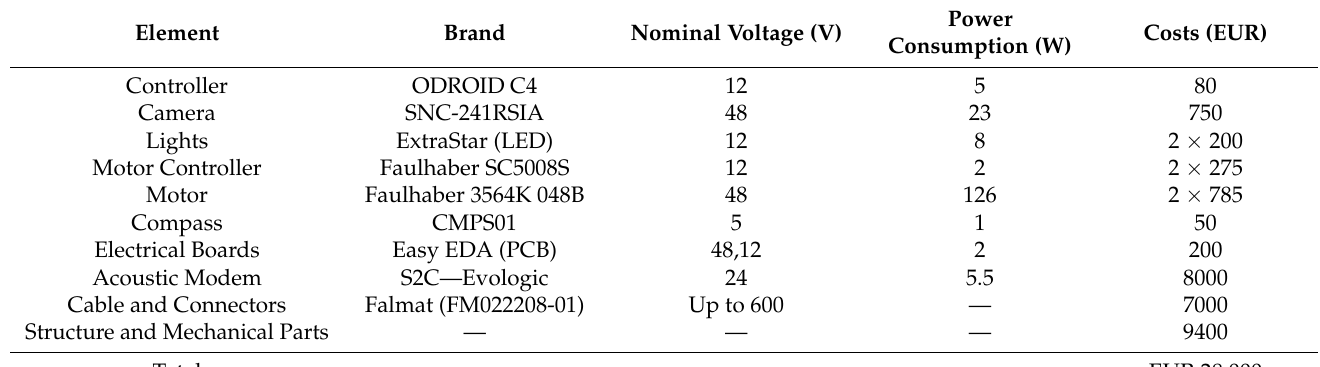
Table 1. The crawler component specifications in terms of brand, power consumption, and detailed costs (plus the total).